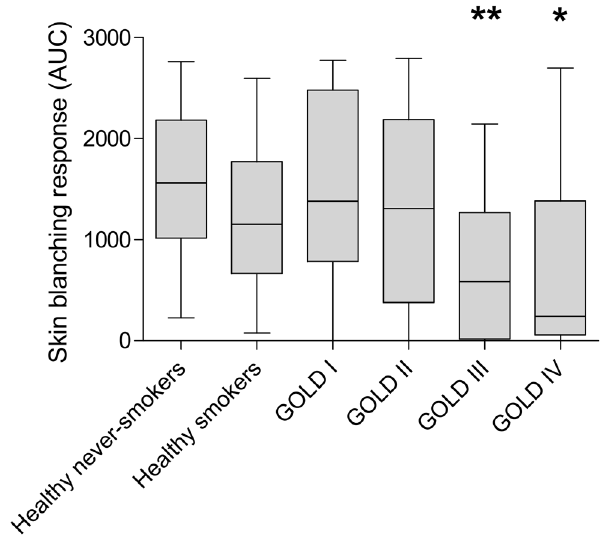
Figure 2. Skin blanching responses in healthy controls and COPD patients GOLD stages I–IV. AUC = area under the dose- response curve. Values are expressed as median [range]. ** significantly different from healthy never-smokers, healthy smokers, GOLD I and GOLD II patients (p-value , 0.05) * significantly different from healthy never-smokers, healthy smokers and GOLD I patients (p-value #